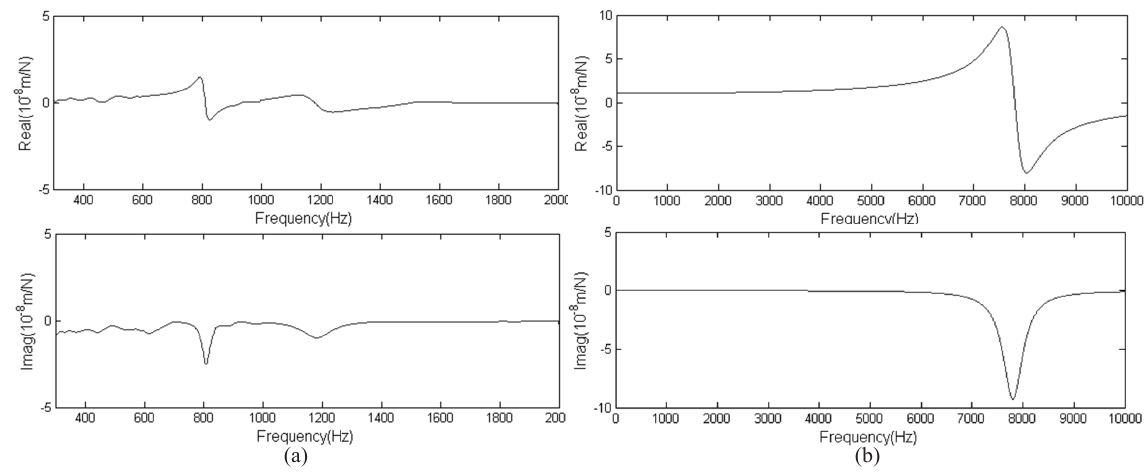
Fig. 7. Frequency response functions of the spindle assembly and the tool. (a) FRF of the spindle assembly measured by impacting tests, (b) FRF of the tool identi fi ed by analytical method. where w max and w min denote the maximum and minimum values of the inertia weight, respectively. c 1 i , c 1 f and c c 2 i , 2 f are the initial and fi nal values of acceleration coef fi cients